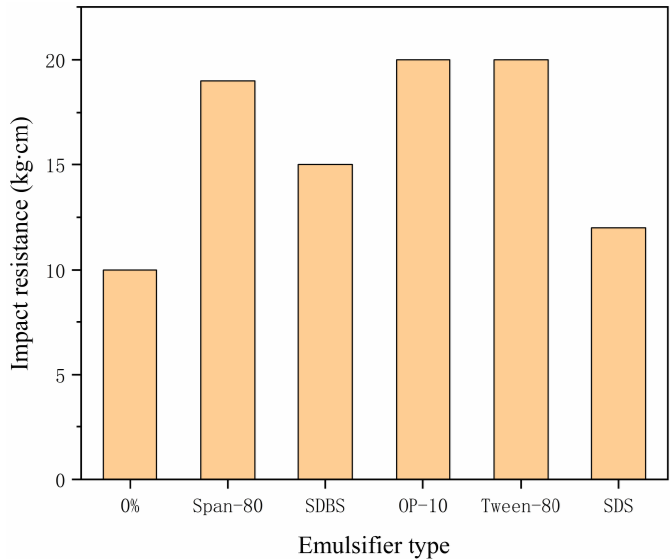
Figure 7. Effect of emulsifier on impact resistance of paint film.